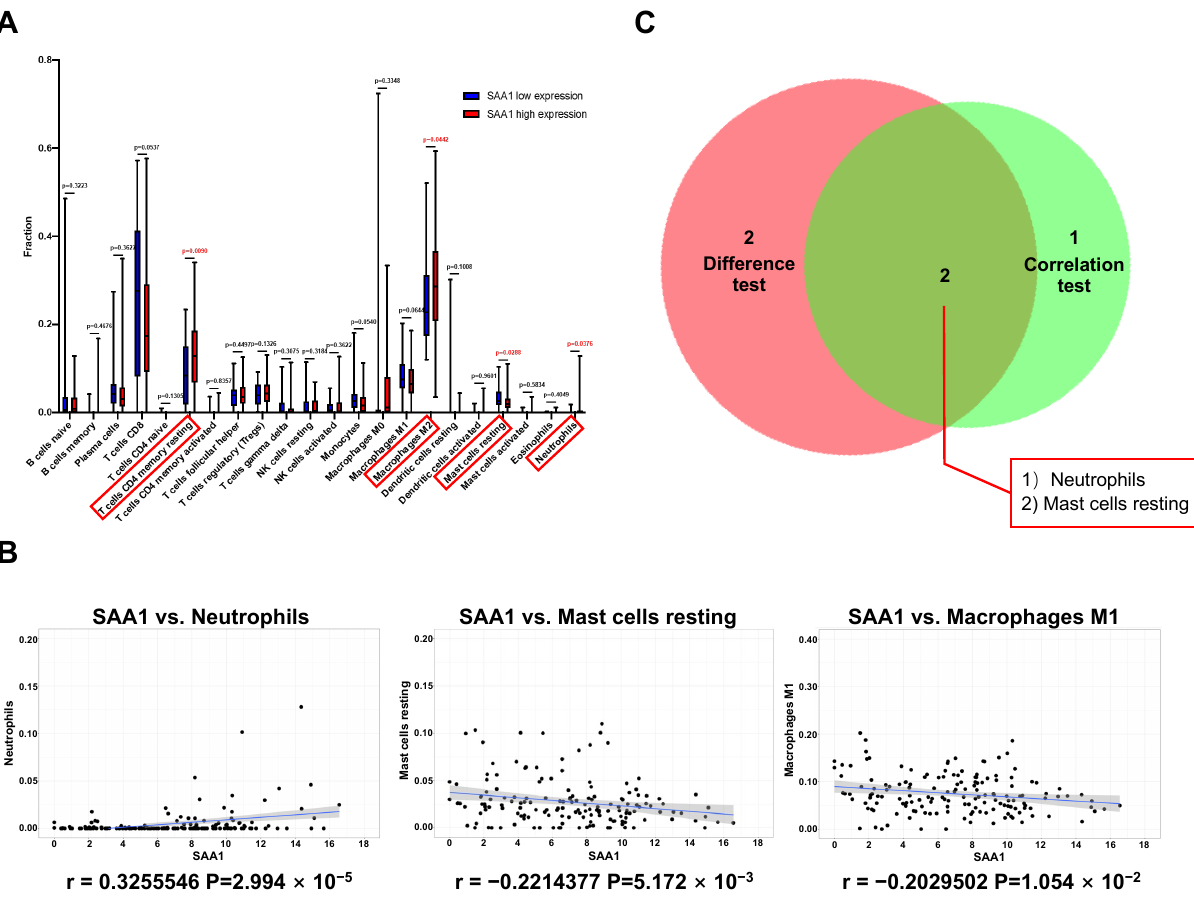
Figure 5. Correlation between TICs fraction and SAA1 expression in ccRCC patients. ( A ) The violin plot showed the abundance differences of 21 kinds of immune cells between SAA1-high group and SAA1-low group in KIRC tumor samples. ( B ) Scatter plot showed that 3 kinds of TICs proportion were significantly correlated with the SAA1 expression ( p < 0.05). ( C ) Venn plot result revealed that neutrophils and mast cells resting were significantly correlated with SAA1 expression by difference and correlation